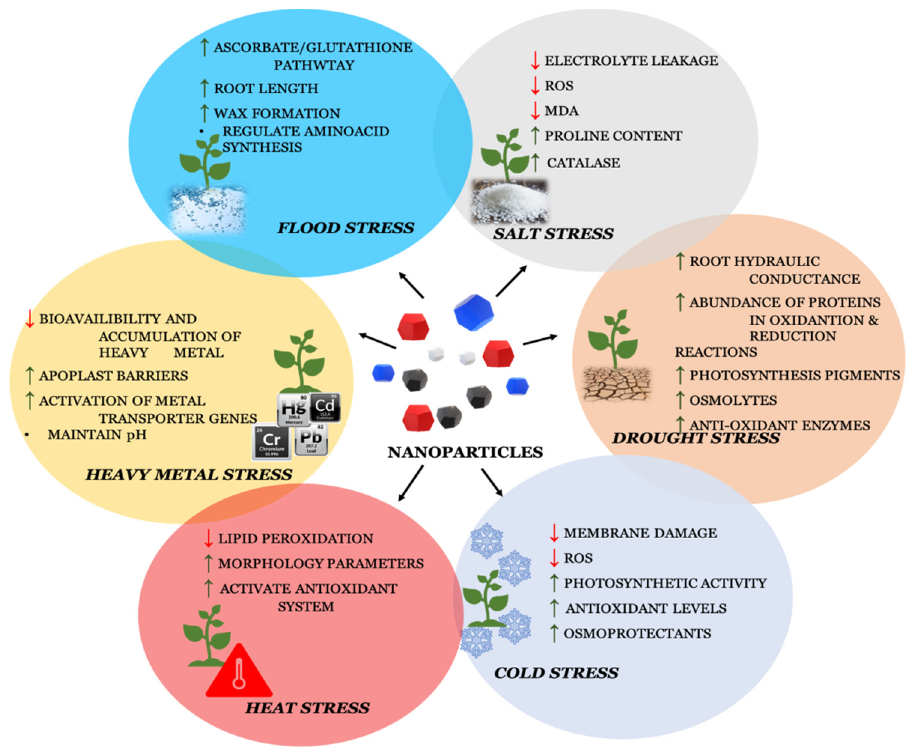
Figure 3. Nanoparticles involved in combating abiotic stress.